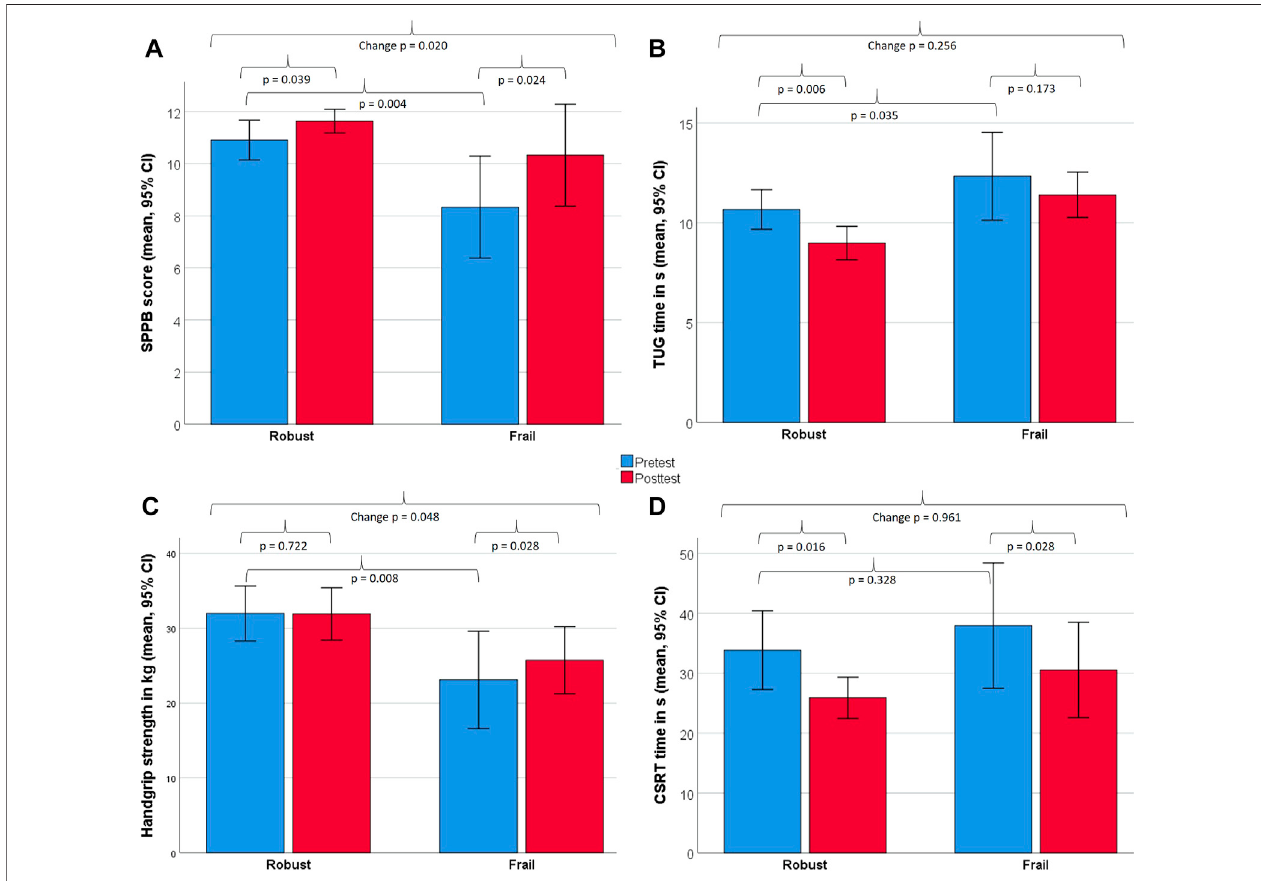
FIGURE 4 | Changes between baseline and 8 weeks in strength and functional capacity measures for robust and frail individuals. Displayed are within- and between-group differences for the Short Physical Performance Battery [SPPB, (A) ], Timed-up & Go test [TUG, (B) ], handgrip strength (C) , Choice Stepping Reaction Time [CSRT, (D) ]. All measures were analysed non-parametrically using the Wilcoxon signed-rank test (within-group) and the Mann – Whitney U-test (between-group).